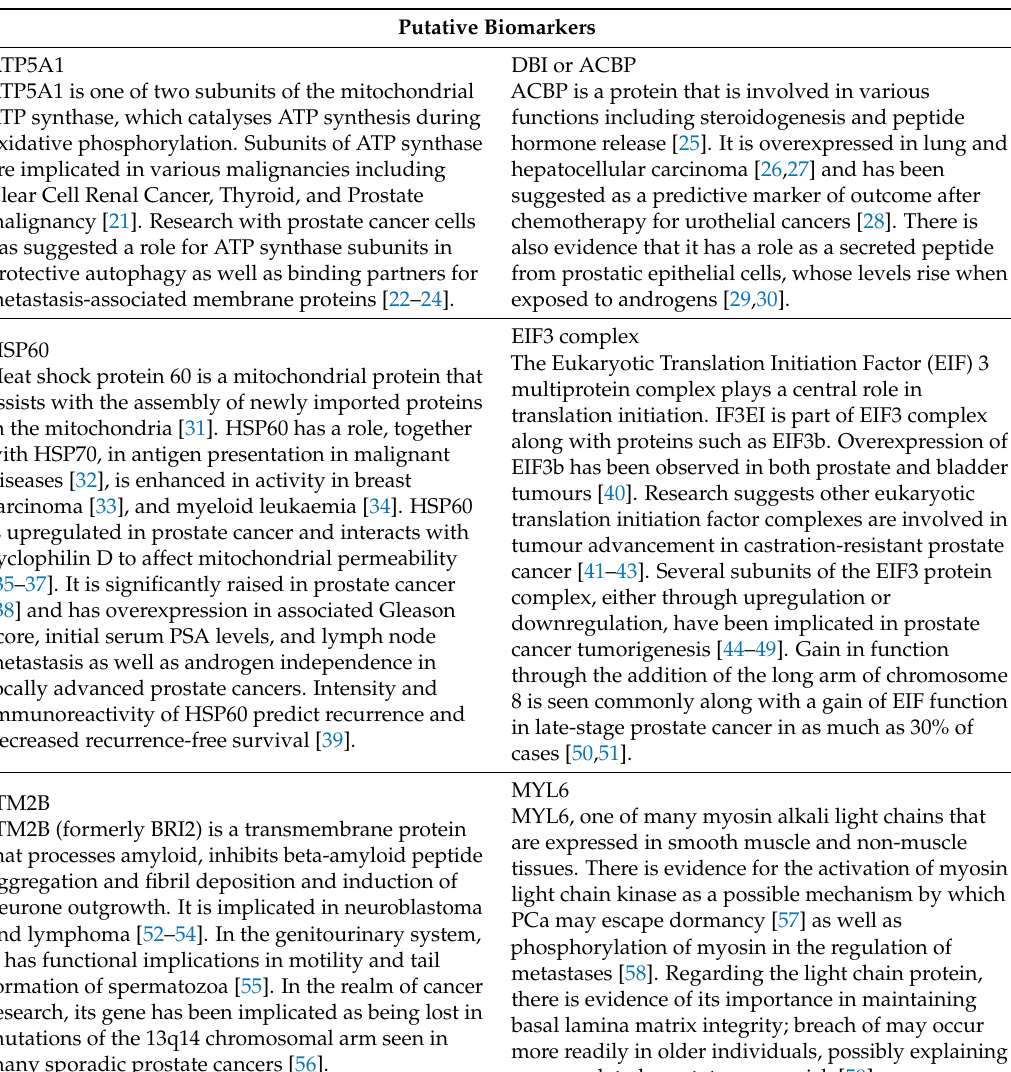
Table 2. Investigated biomarkers and their empirical evidence relating to cancer